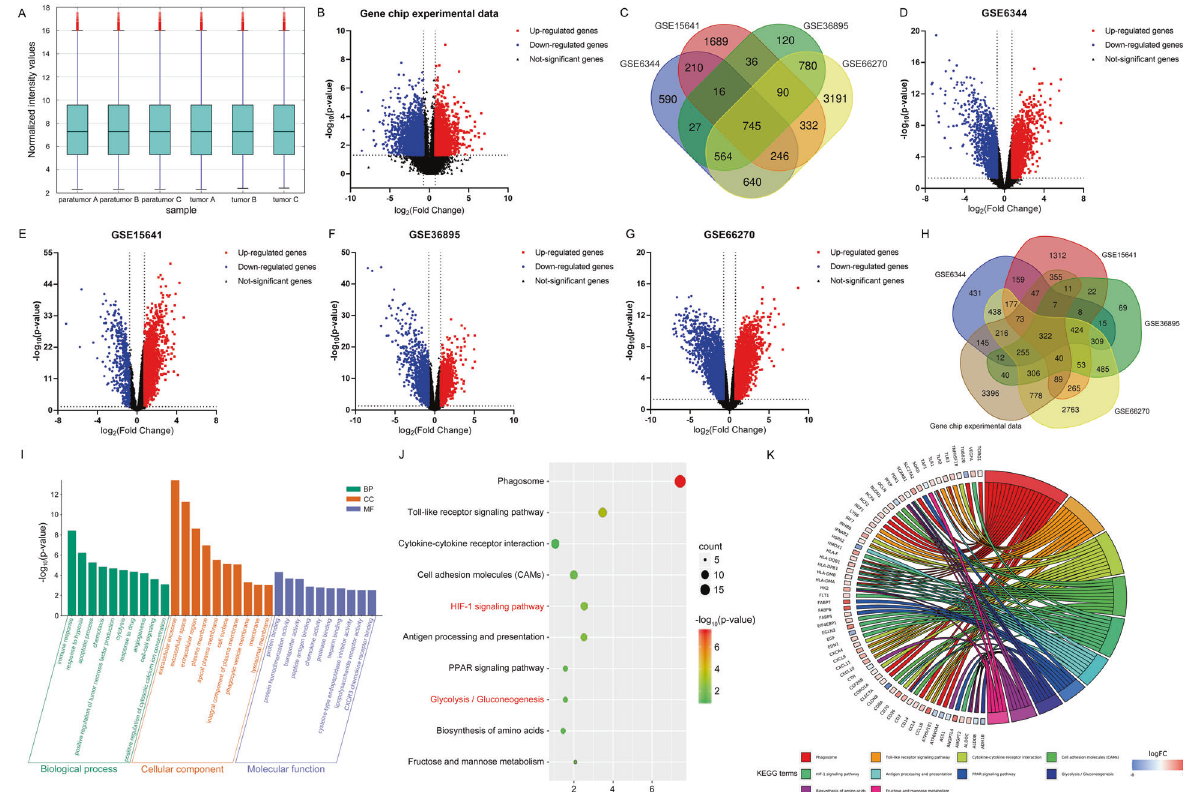
Fig. 1 Differential gene expression pro fi ling in KIRC based on gene chip experiment results and online GEO database. A Box plot of all the tested samples in the dataset after normalization. All six samples in the dataset were normalized, and the distributions of the log2-ratios were nearly same. B The volcano map of DEGs which were identi fi ed in KIRC from our microarray experiment results. C The 745 common DEGs were obtained among the four online datasets by the Venn diagram analysis. D – G The volcano map of DEGs identi fi ed from four online datasets including GSE6344, GSE15641, GSE36895, and GSE66270. The red points represented upregulated DEGs screened on the basis of fold change >0.75 and a corrected P value of <0.05. The blue points represented downregulated DEGs with a fold change < − 0.75 and P value <0.05. The black points represented genes with no signi fi cant difference. H 322 crucial DEGs related to KIRC were selected by taking intersection of DEGs from four online GEO datasets (GSE6344, GSE15641, GSE36895, and GSE66270) and our gene chip experiment results. I GO functional analyses were performed to investigate the biological processes (BP), cellular component (CC), and molecular function (MF) terms enriched in 322 crucial DEGs related to KIRC. J DEGs were signi fi cantly enriched in HIF-1 signaling pathway and glycolysis among the top ten most signi fi cantly enriched KEGG pathways. K Chord diagram for KEGG analysis revealed that several PGK1-related signaling pathways were indicated to aberrantly alter in